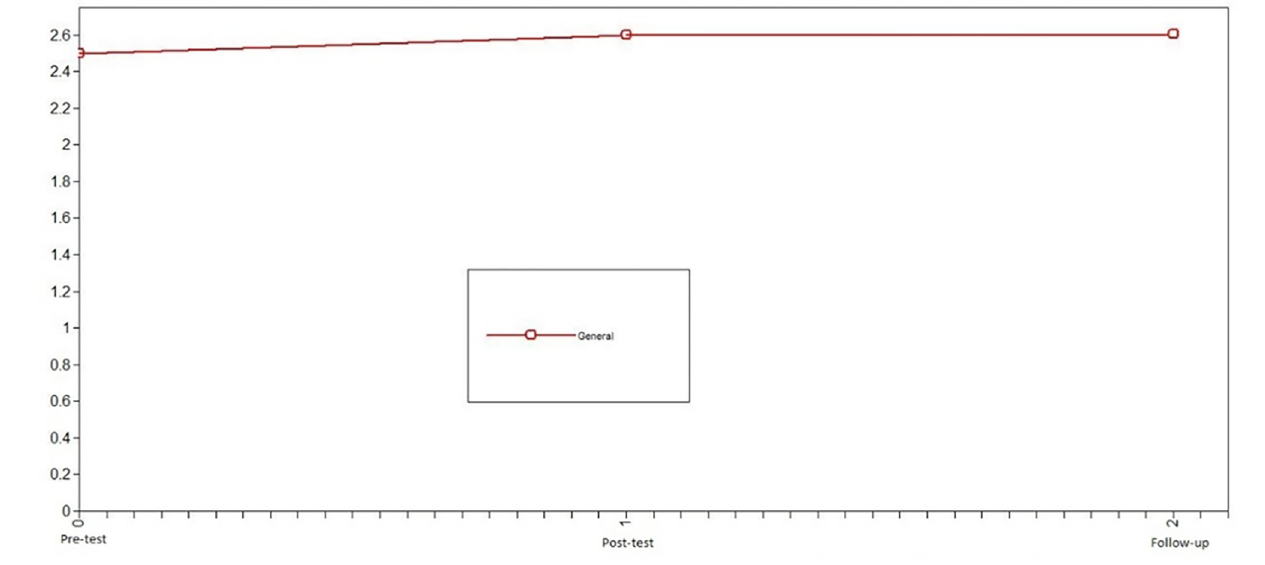
PLOS ONE | https://doi.org/10.1371/journal.pone.0272922 October 7,